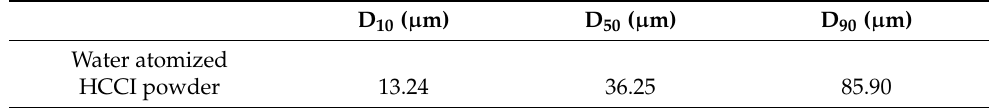
Table 1. The chemical composition of the HCCI (wt.%).